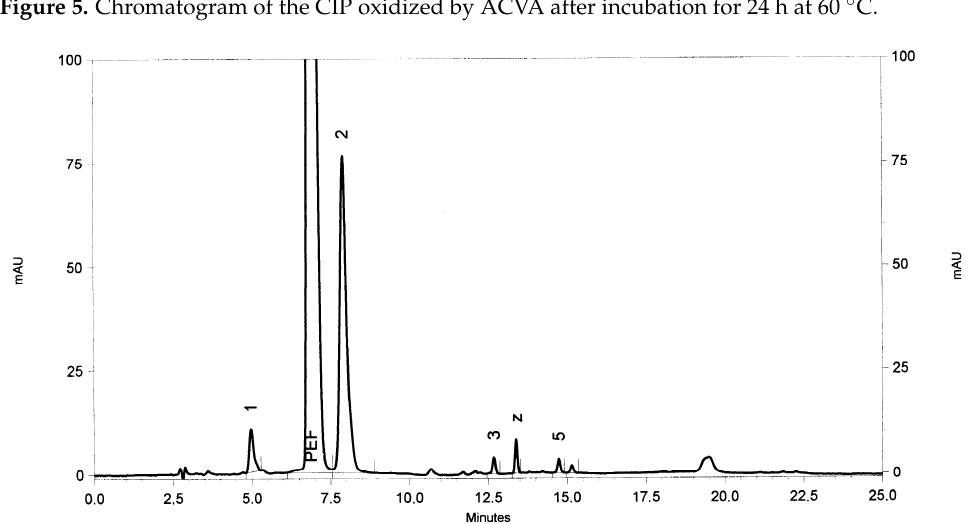
Figure 5. Chromatogram of the CIP oxidized by ACVA after incubation for 24 h at 60 °C. In the case of the oxidation of PEF by ACVA, the results showed that the process causes the formation of one main degradation product with a percentage of above 9.50% (t R ≈ 7.89 min), one with an amount of above 1.14% (t R ≈ 5.00 min) and the 3 others with a